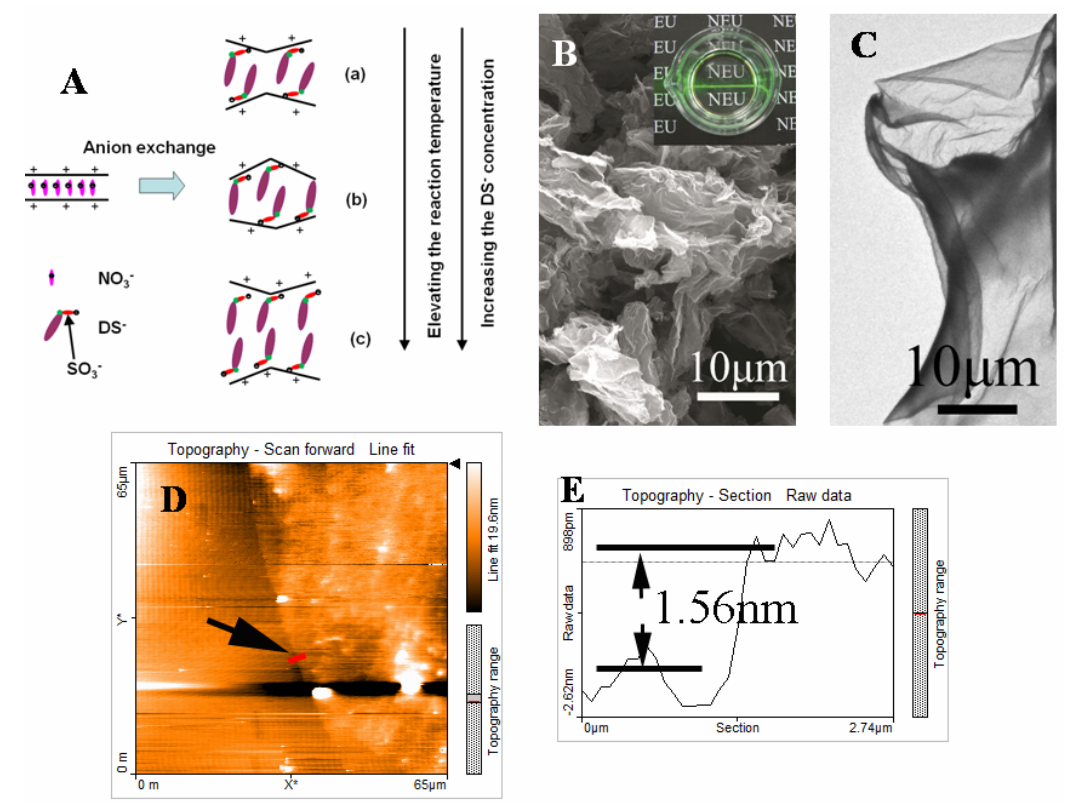
Fig. 5 (A) Schematic illustration of DS  arrangement in the interlayer, and (B) FE-SEM, (C) TEM, and (D) AFM micrographs showing morphologies of the nanosheets exfoliated from (Y,Eu) 2 (OH) 5 NO 3 · n H 2 O crystals (0.3mm-sized). (E) Height profile along the red line marked in (D). The inset in (B) shows the appearance of a colloidal suspension of the nanosheets in formamide with a clearly observable Tyndall effect under laser beam irradiation. Reproduced with permission from Ref. [25], © National Institute for Materials Science